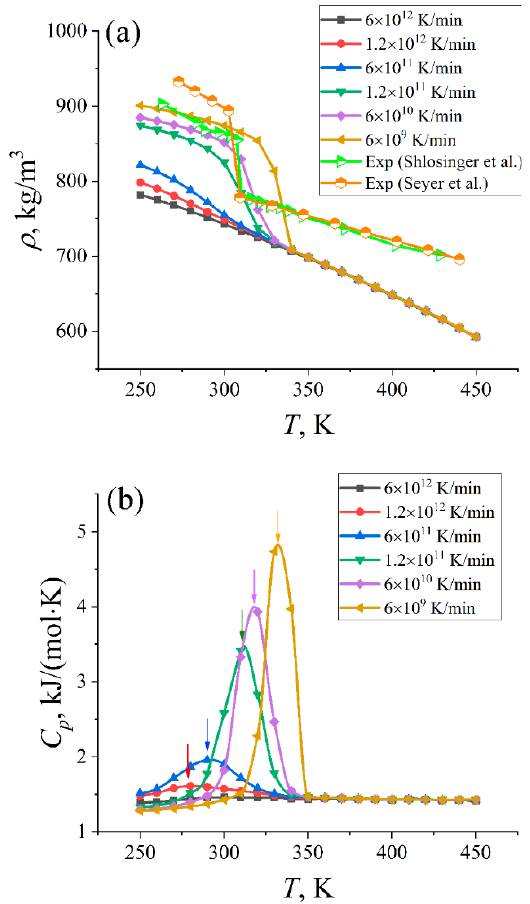
Figure 1. ( a ) Mass density ρ of n-eicosane samples as a function of temperature T for different cooling rates. Error bars (standard errors) are of the size of symbols and are not shown. For the sake of comparison, the experimental data [20,21] are also shown. ( b ) Molar specific heat capacity C p as a function of temperature for different cooling rates. The peaks corresponding to the crystallization of n-eicosane samples are marked by